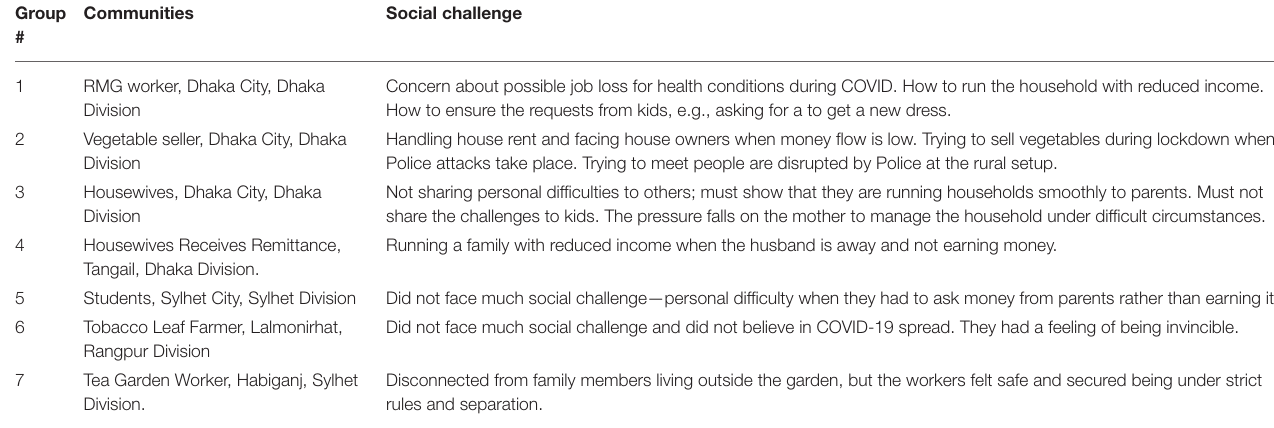
TABLE 3 | Major social challenges faced by communities. Group